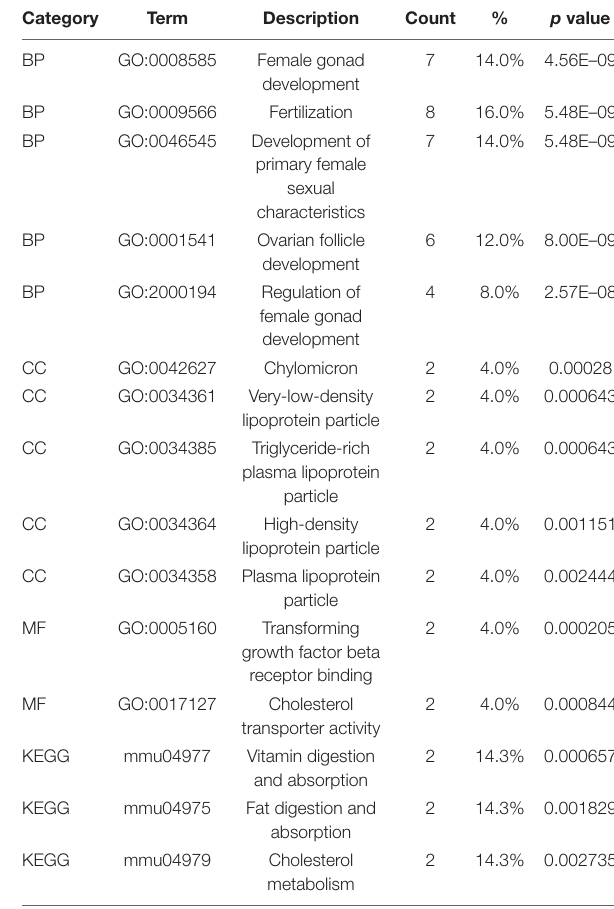
TABLE 3 | Functional enrichment analysis of downregulated genes in the old mouse ovary compared to young mouse. Category Term Description